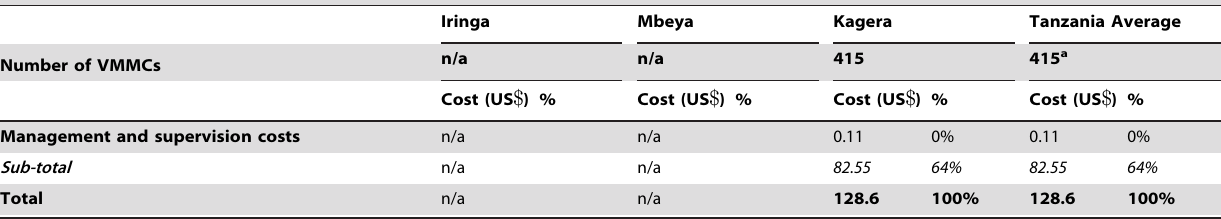
C) VMMC unit costs by region and service delivery model: mobile/island sites.